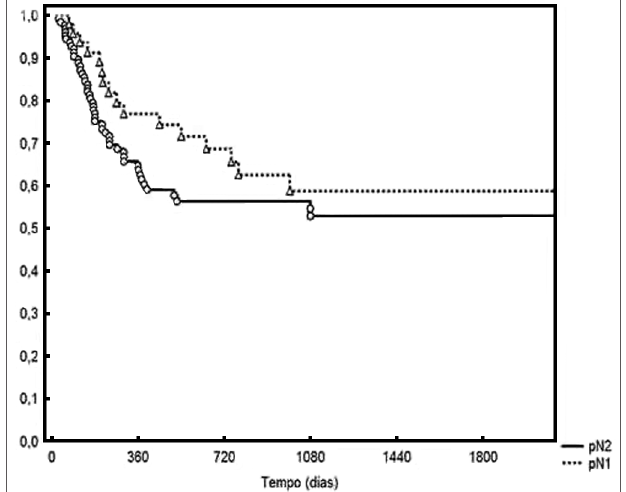
Figura 4. Controle locorregional conforme o estadiamento pN.